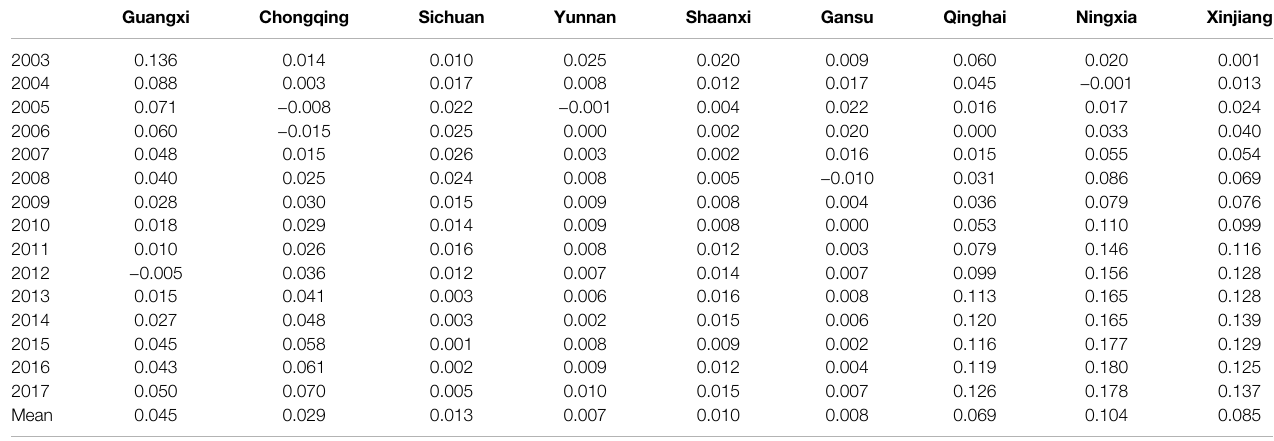
TABLE 4 | The regulating effect of human capital on energy ef fi ciency.